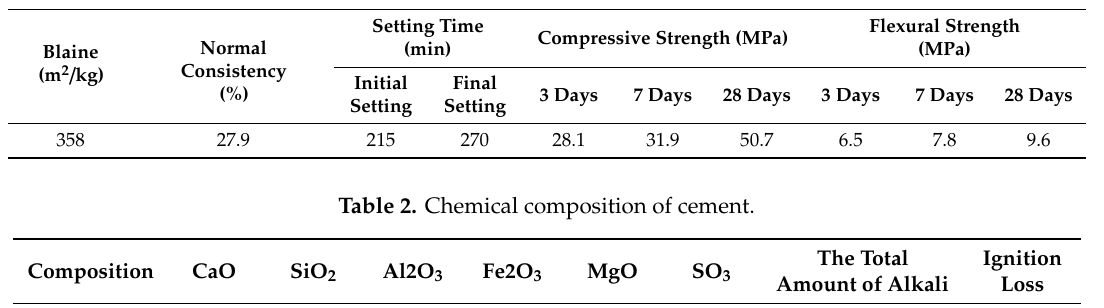
Table 1. Physical properties of the cement.